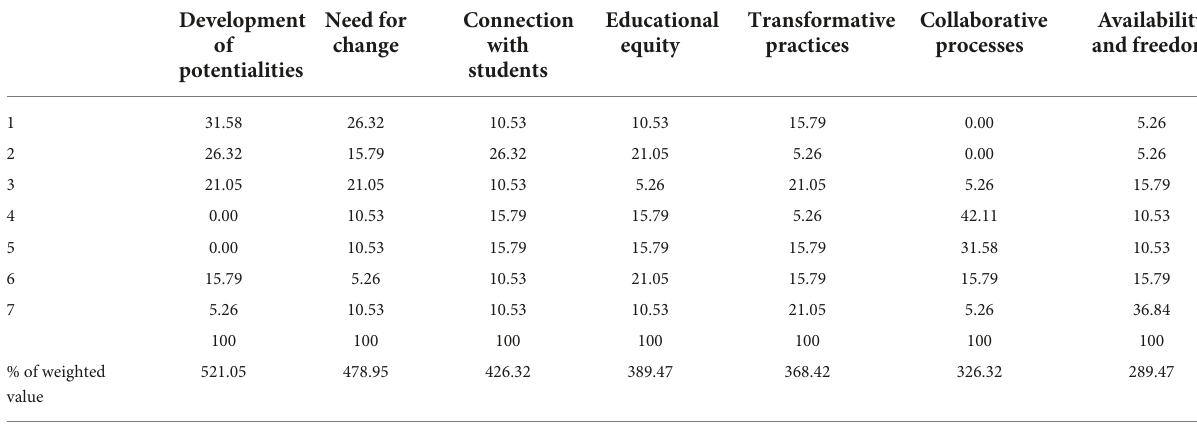
TABLE 7 Opinions on the objectives of educational innovation, from highest to lowest priority.